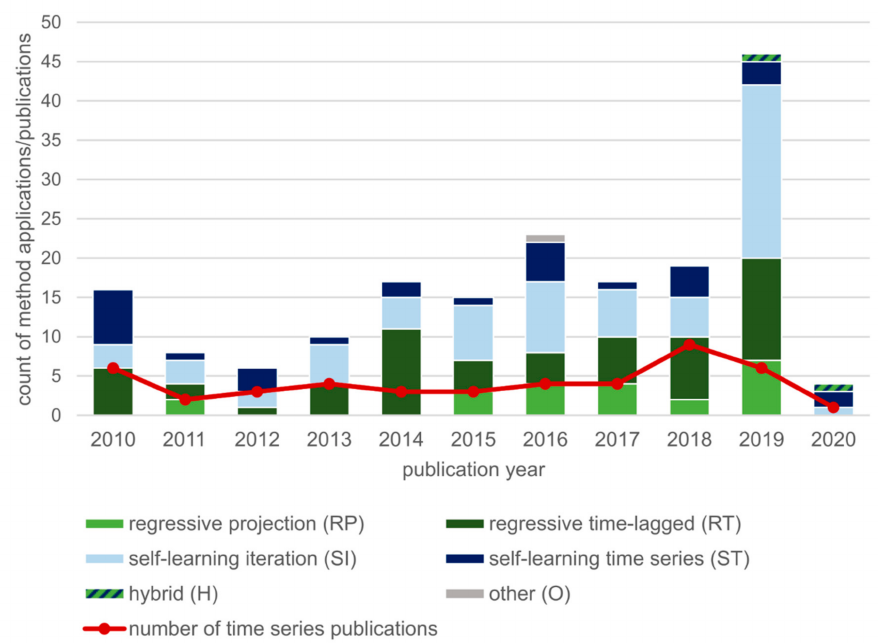
Figure 7. Number of forecasting methods employed by type per publication year. One research article may employ multiple forecasting methods. The red line shows the number of studies in each year using remotely sensed time series data as input (c.f. Section